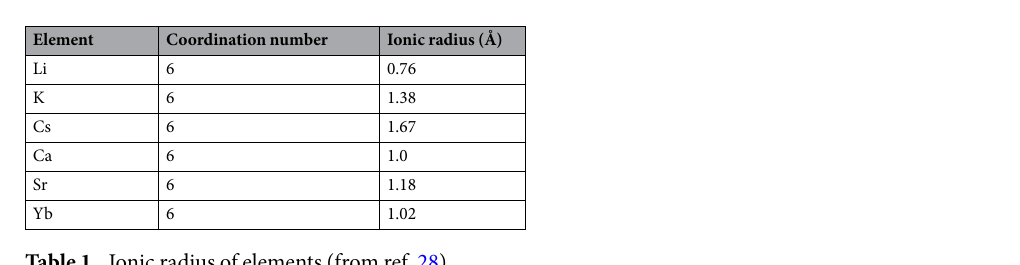
Table 1. Ionic radius of elements (from ref. 28).